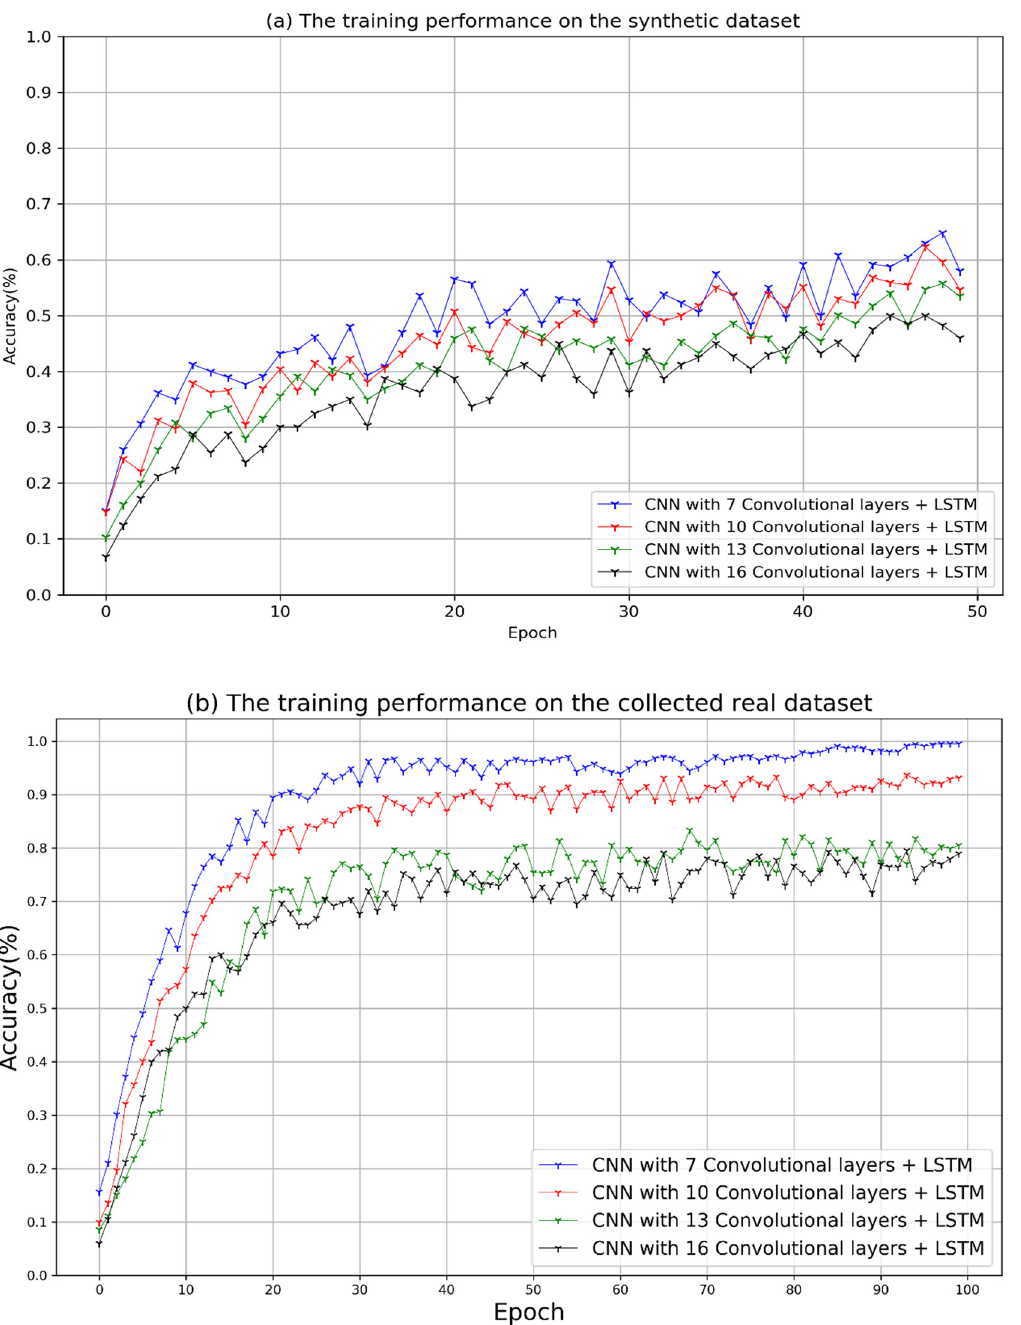
Figure 7. The performance of the whole LP recognition, which includes ( a ) the performance on the synthetic data and ( b ) the performance on the collected data.